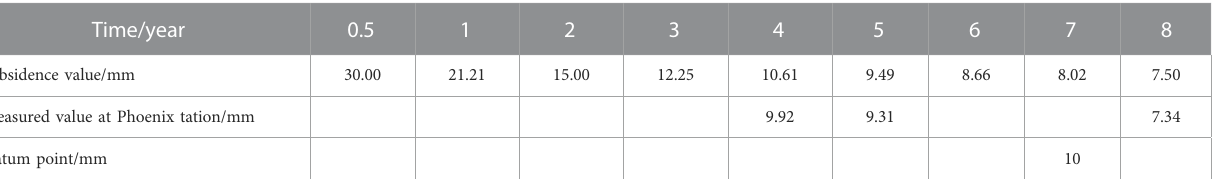
TABLE 5 Fitting predicted subsidence value and measured